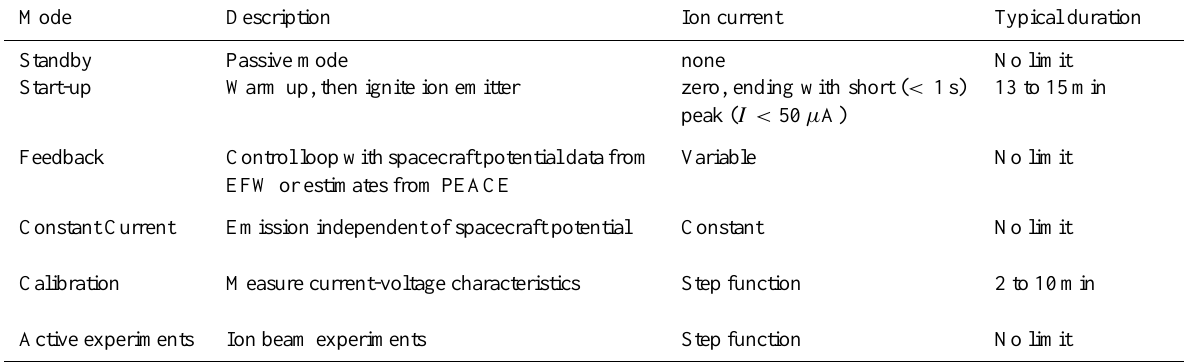
Table 2. ASPOC mode